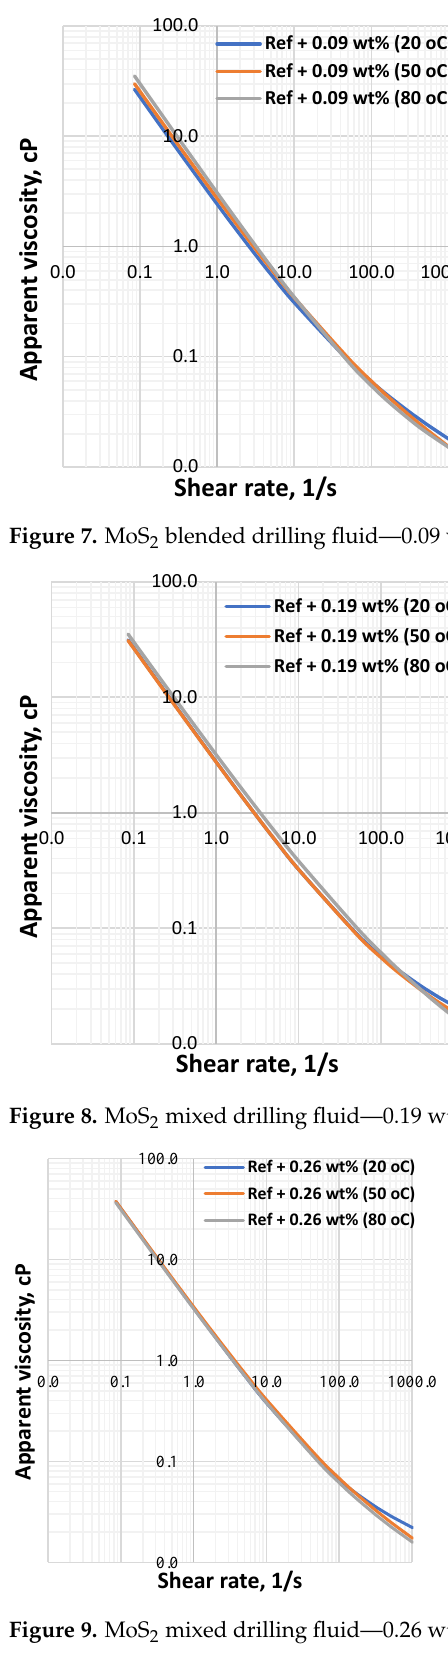
Figure 9. MoS 2 mixed drilling fluid — 0.26 wt.%.